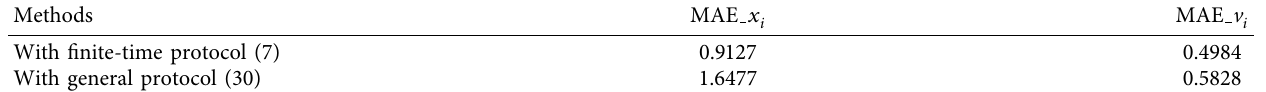
Figure 4: Position and velocity state error. Table 1: The mean absolute error of the two methods.